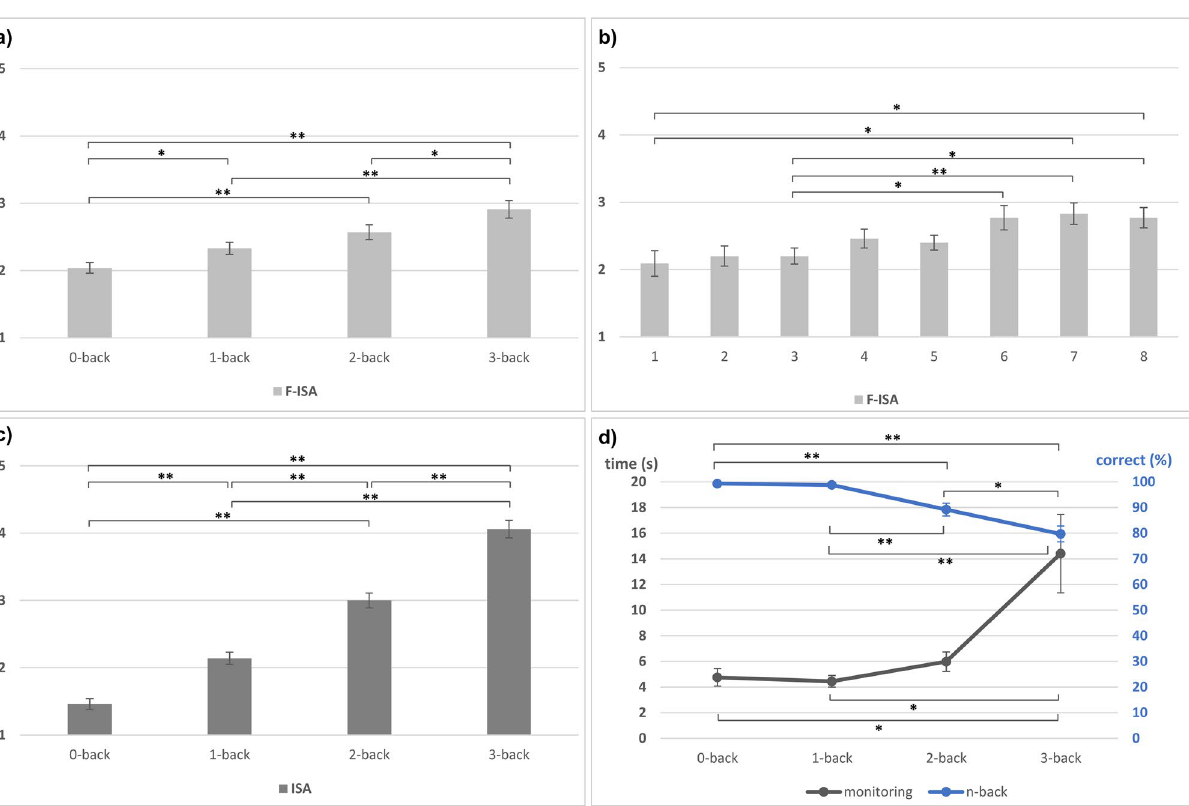
Figure 1. Subjective and performance measures. Error bars indicate SE. Significant comparisons marked p < 0.05* and p < 0.01**. ( a ) Mean F-ISA ratings per n-back level. ( b ) Mean F-ISA ratings across experimental blocks. ( c ) Mean ISA ratings per n-back level. ( d ) Mean monitoring and n-back performance per n-back